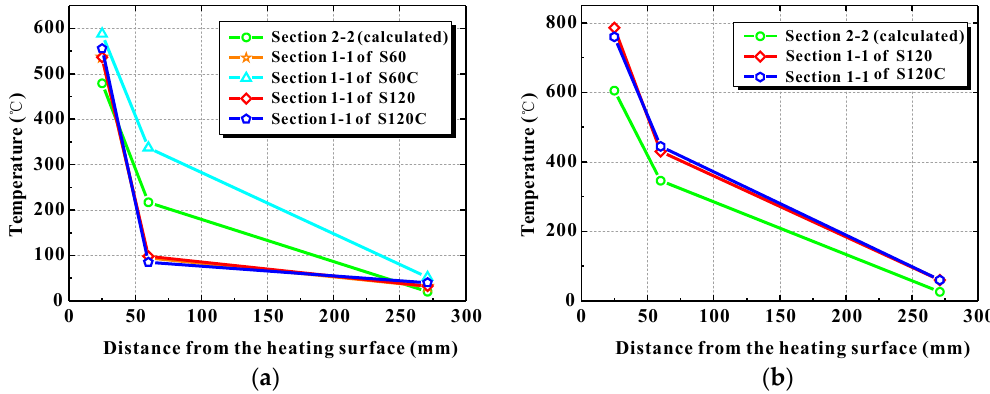
Figure 12. Comparison between measured temperatures at Section 1-1 and calculated temperatures at Section 2-2. ( a ) Heating time = 60 min; ( b ) heating time = 120 min.